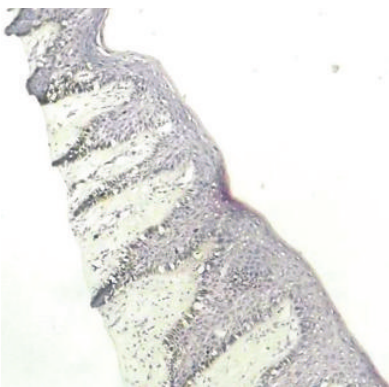
Figure 4: Increase in the number of melanocytes in the basal and suprabasal layers (Masson Fontana, 10 ×